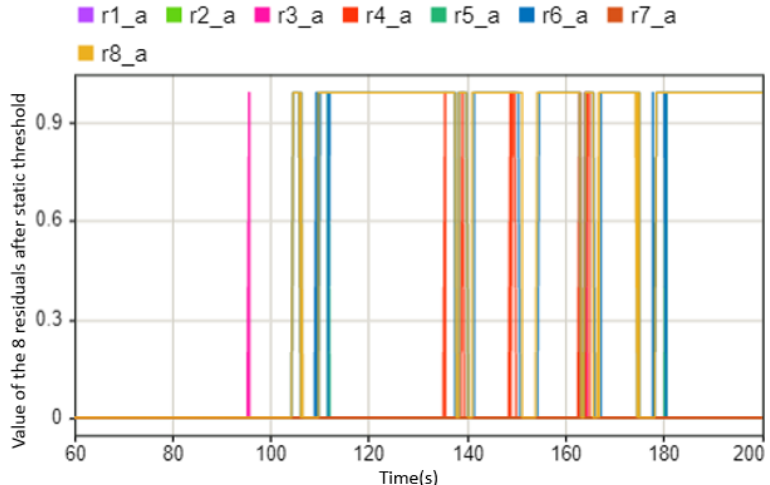
Figure 16. The values of the eight residuals after threshold. This case shows when driving mo- tor fails between 104 s and 200 s (0 means there is no abnormal situation, 1 means there is an abnormal situation).